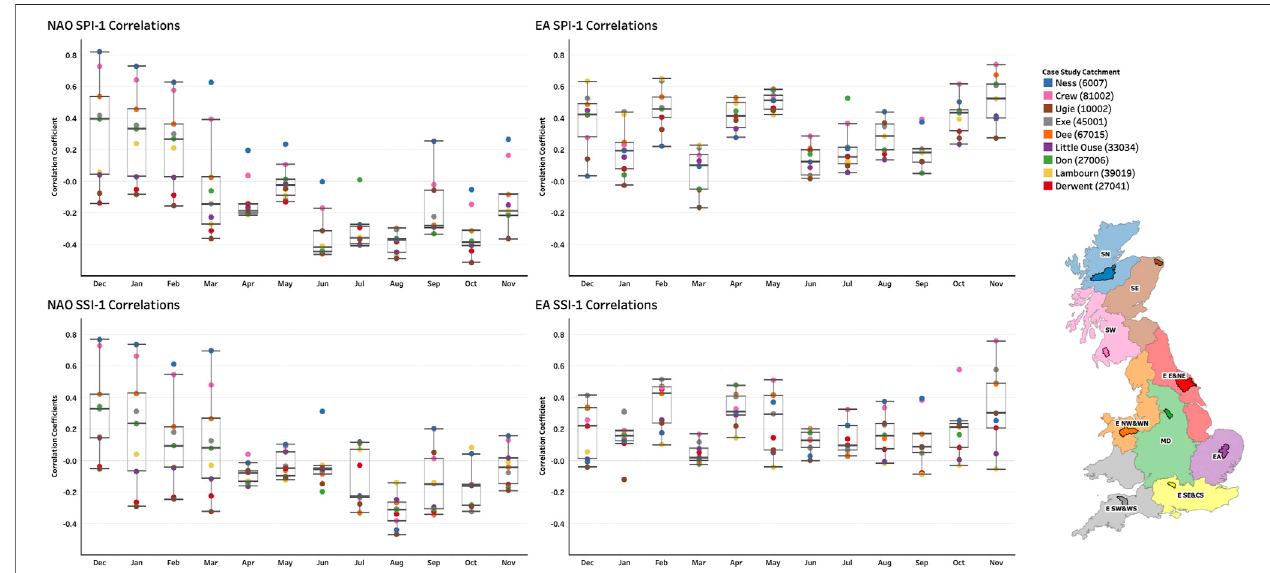
FIGURE 4 | Monthly correlation analyses between the NAO/EA and catchment SPI-1 and SSI-1 values for the nine case study catchments.